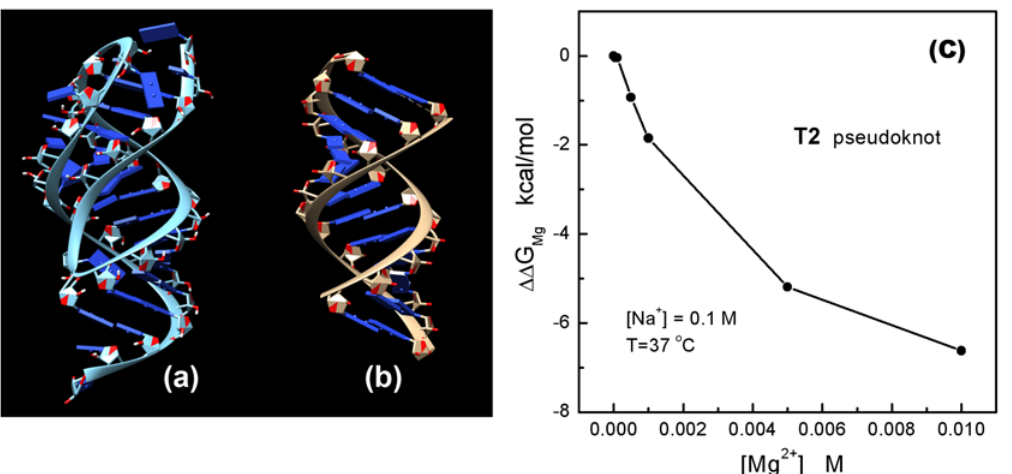
Fig 6. The Mg 2+ -induced folding stability ΔΔ G Mg 2+ for the T2 pseudoknot. (a) and (b) show the 3D structures of T2 pseudoknot (the folded state) and the 24-nt A-form helix, respectively; (c) shows the Mg 2+ -induced folding stability.